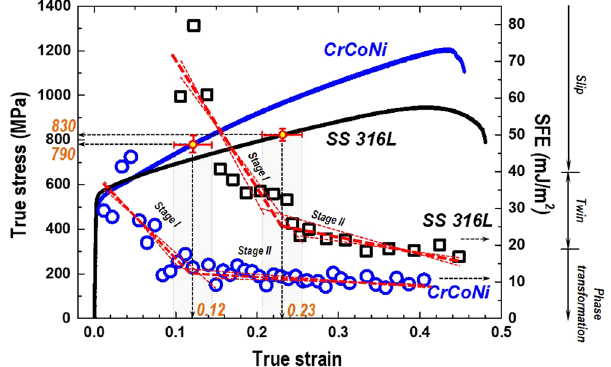
Figure 8. True stress-strain curves and stacking fault energies (SFE, mJ/m 2 ) as a function of true strain. Significant variance of SFE is shown between stage I (initial) and stage II (stabilized). Linear fitting with adjacent points of 0.23 and 0.12 estimates the critical twinning stresses ( σ tw ) of AM SS 316 L and AM CrCoNi alloys, respectively. The strain rate is both 2 × 10 − 5 s − 1 . Typical dominant deformation mode in austenitic stainless steels was referred on side of the